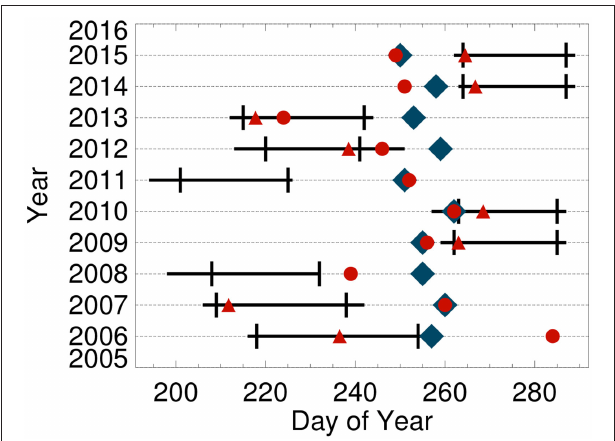
FIGURE 2 | Dates of JOIS cruises on which ice watches were performed, with ice watch time periods bounded by vertical black lines. The time of freeze up is shown for several different methods of estimating freeze up. Red triangles show when the ocean surface was visually observed to be freezing. Red circles are the date of minimum ice extent in the Beaufort region. Blue diamonds are Arctic minimum ice extent